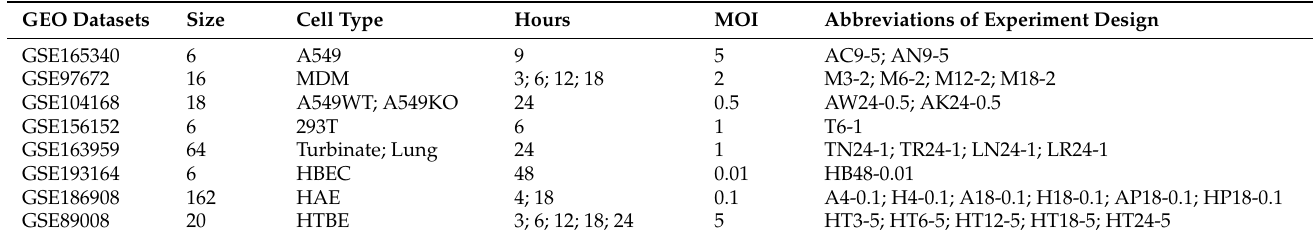
Table 1. The main features of 8 selected datasets in this